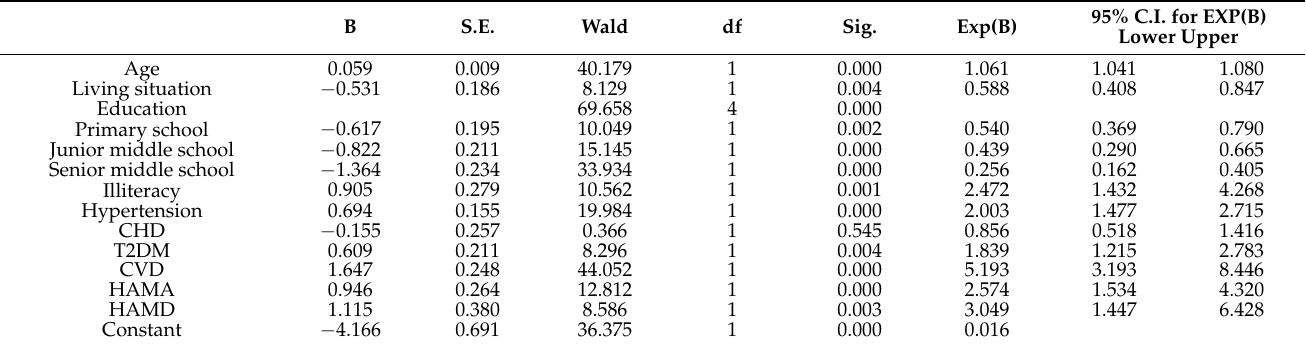
Table 7. Multivariate logistic regression analysis of the risk factors for senile dementia.